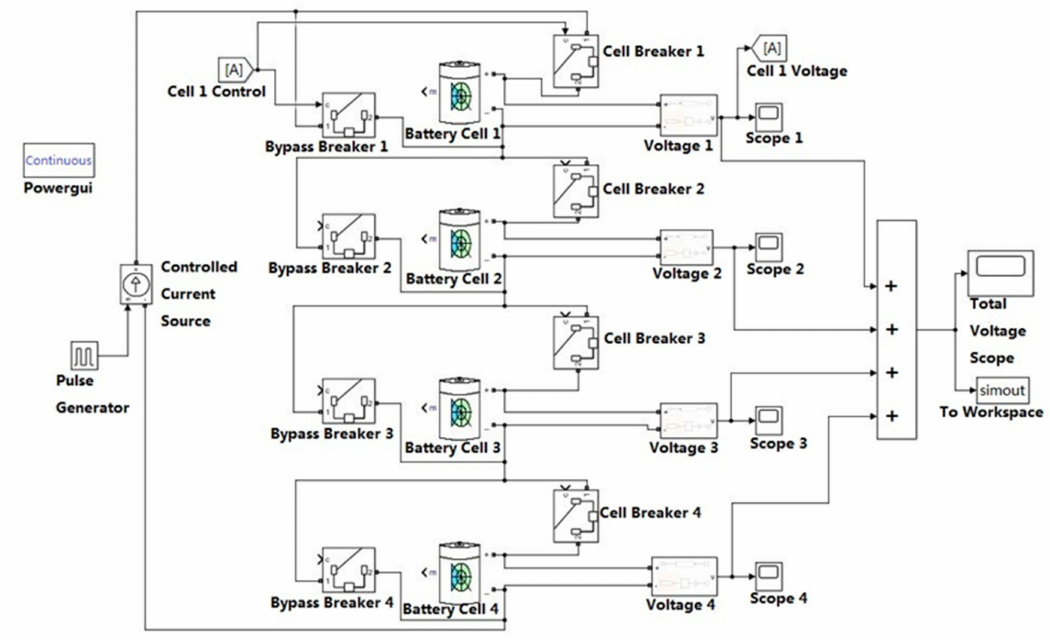
Figure 5. A Simulink battery module model consisting of four series-connected cells.